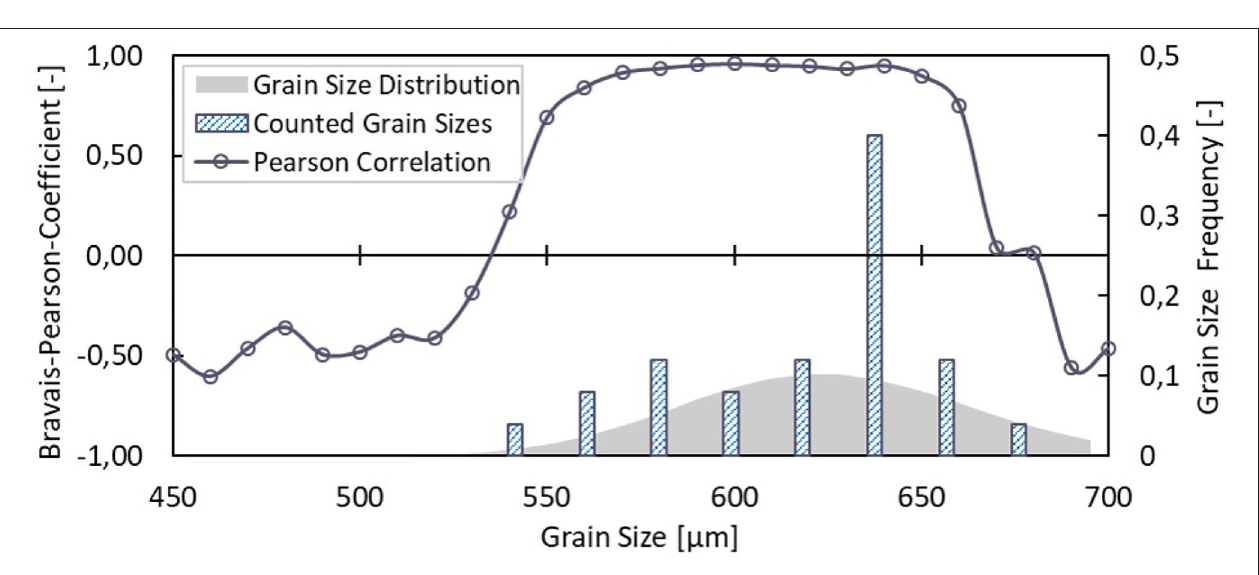
Using the discrete grain size distribution, a normalized grain size distribution of the form f ( D ) = a · e cD · D b was matched (Nakamura et al., 2001). Fitted was